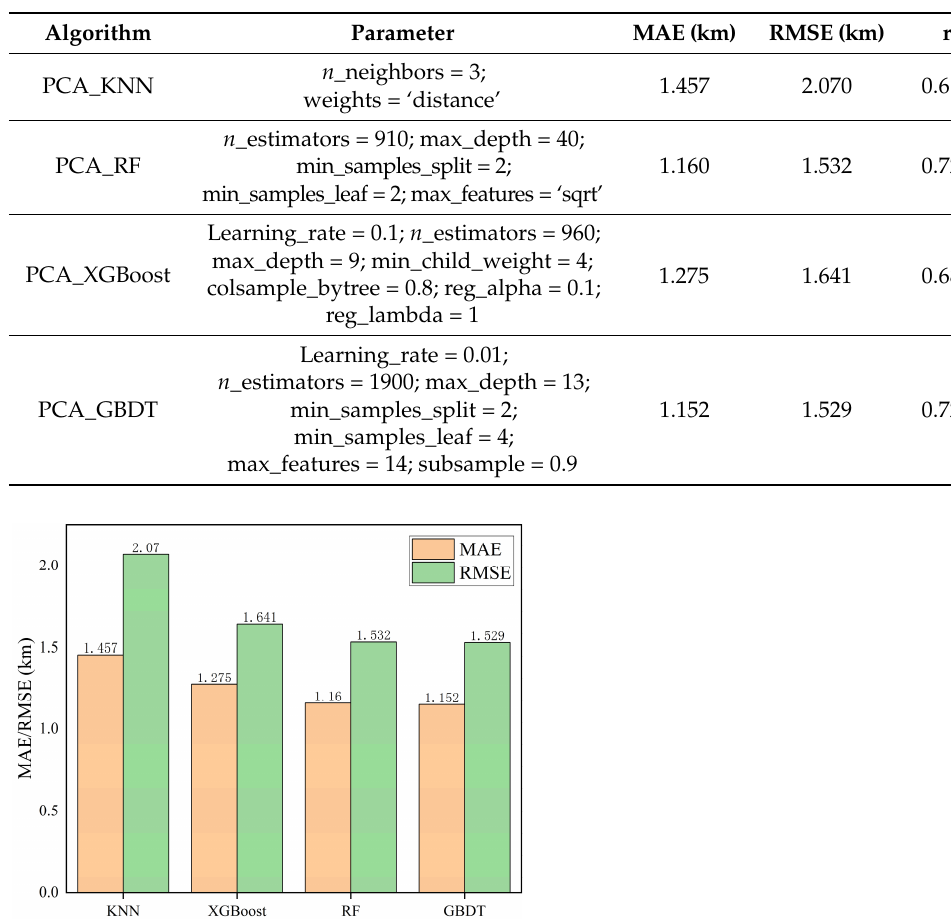
Table 5. Comparison of VBH prediction errors for the four ML algorithms based on optimal parameters.